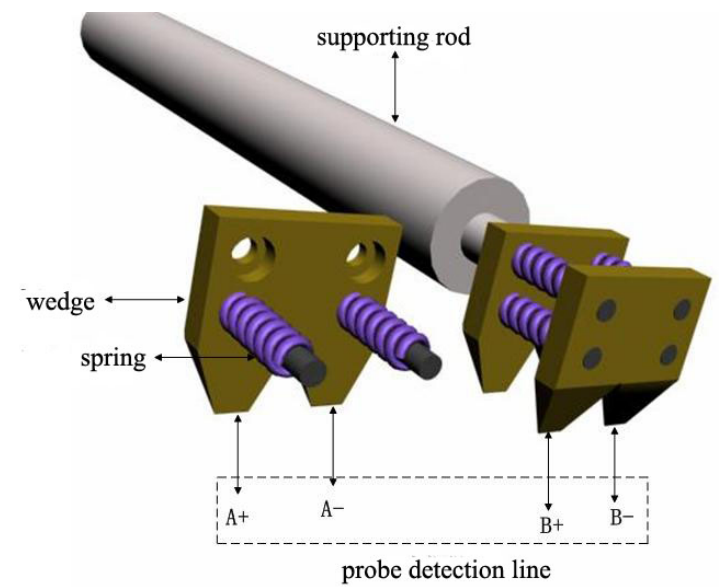
Figure 4. Four-quadrant wedge